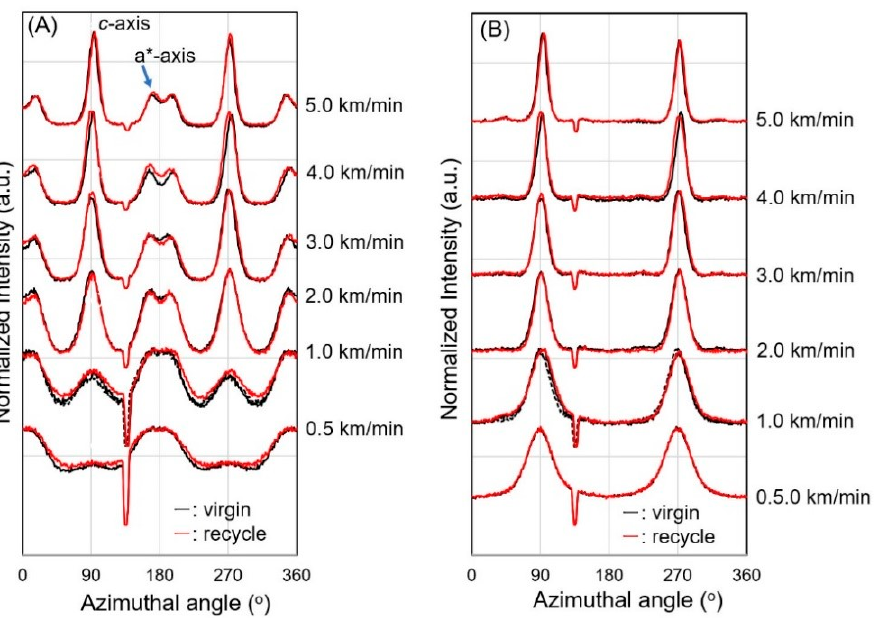
Figure 9. Azimuthal intensity distributions for ( A ) (110) and ( B ) (040) reflections observed through WAXD measurements for virgin PP and recycled PP fibers, melt-spun at different take-up